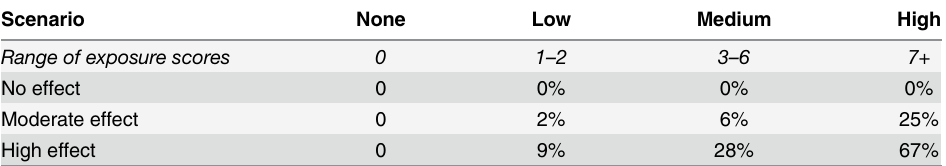
Table 2. Additional mortality suffered by kit foxes with varying amounts of rodenticide